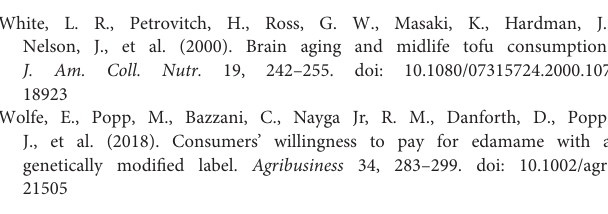
Conflict of Interest: The authors declare that the research was conducted in the absence of any commercial or financial relationships that could be construed as a potential conflict of